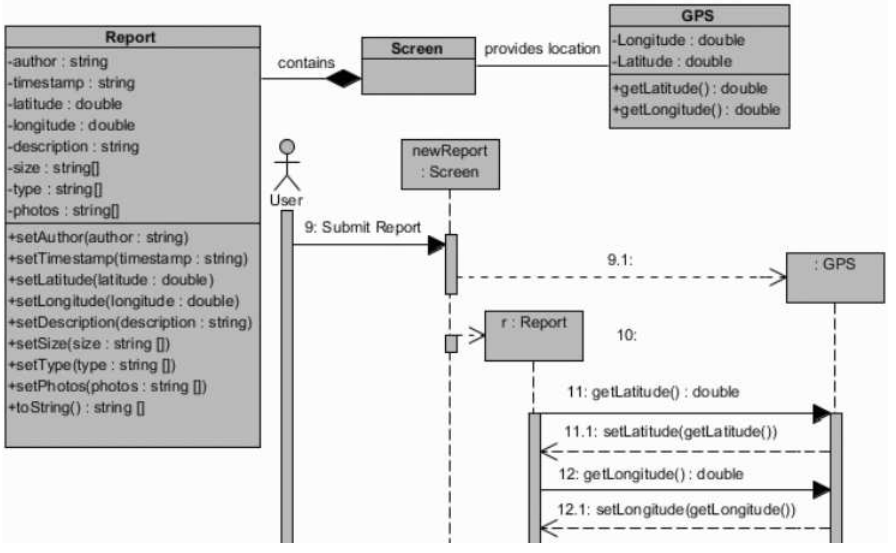
Figure 1. Part of the model in UML from task T1